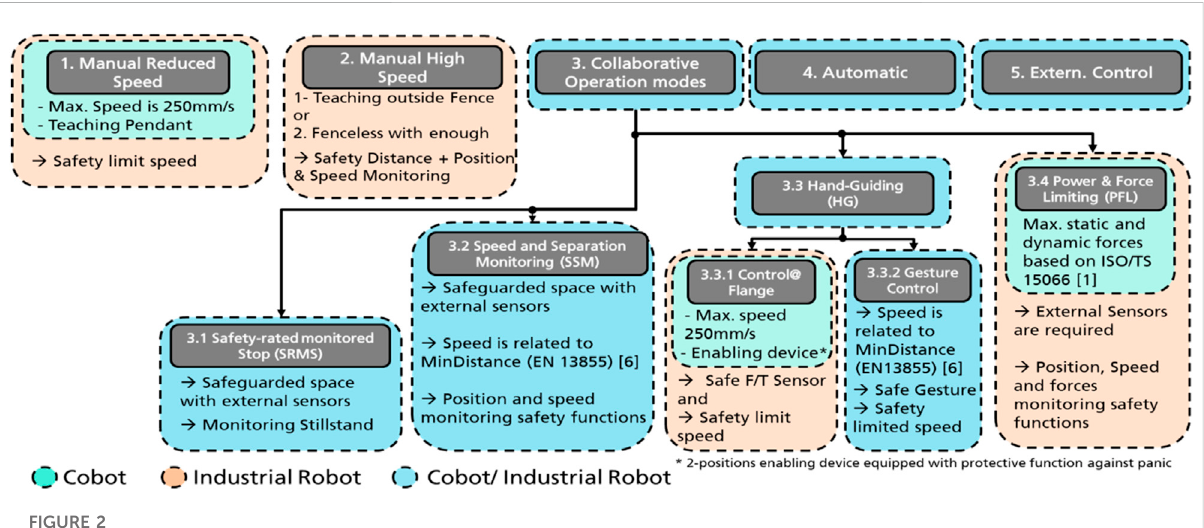
Possible Operation modes related to cobots and industrial